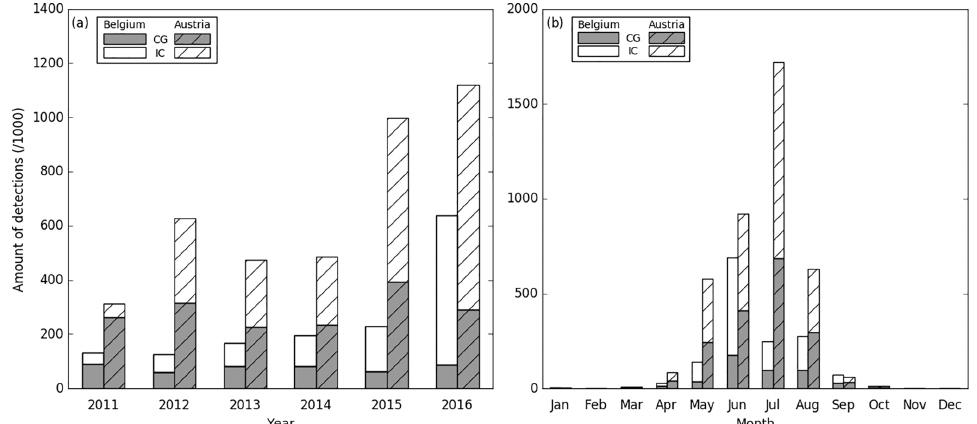
Figure 2. Distribution of the (a) annual and (b) monthly CG and IC counts as observed within the areas indicated over Belgium and Austria in Fig.